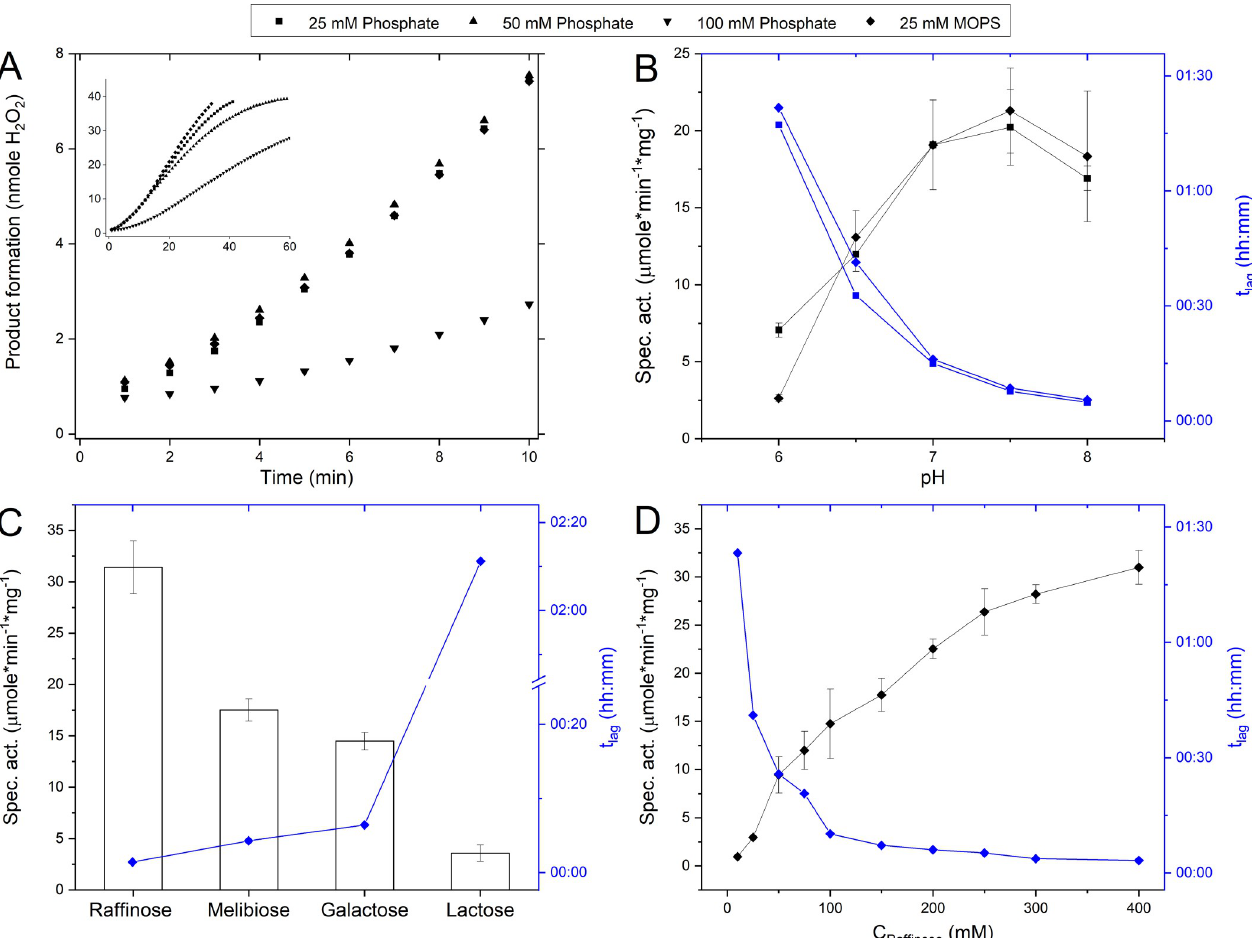
Fig 4. Lag-phase of Pru AA5_2A activity. The lag-phase (t lag ) is defined as the time from initiation of the reaction (T = 00:00) to where the maximum slope crosses the x-axis. (A) Impact of buffer type and concentration on rate of product formation during oxidation of 300 mM raffinose (pH 7.5). (B) Impact of pH on reaction rate and t lag , during oxidation of 300 mM raffinose. pH was established using 25 mM sodium phosphate buffer and 25 mM MOPS. (C) Impact of substrate on reaction rate and t lag , where each substrate was prepared to 300 mM in 25 mM MOPS (pH 7.5). (D) Impact of substrate concentration on reaction rate and t lag , where raffinose was prepared in 25 mM MOPS (pH 7.5). n = 4 error bars indicate standard deviation.